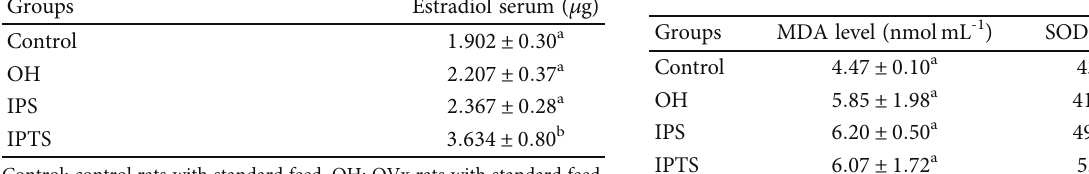
Table 3: MDA levels and SOD activity in the blood of experimental rats.